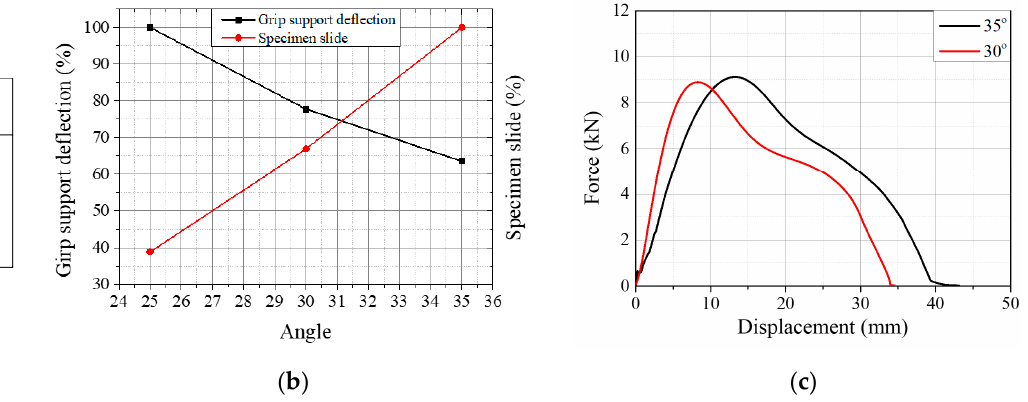
Figure 4. ( a ) Tapered support angle of push-in grip for TWT specimens; ( b ) finite element analysis result; ( c ) experimental load–displacement curves with 30° and 35° grip support angle.